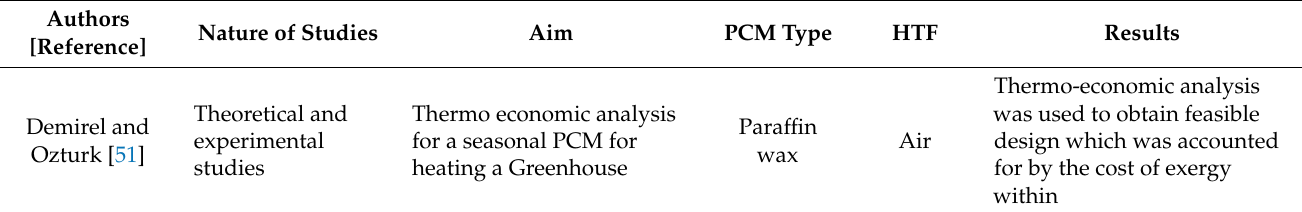
Table 2. Results of some of the studies presented on solar greenhouses and the PCM